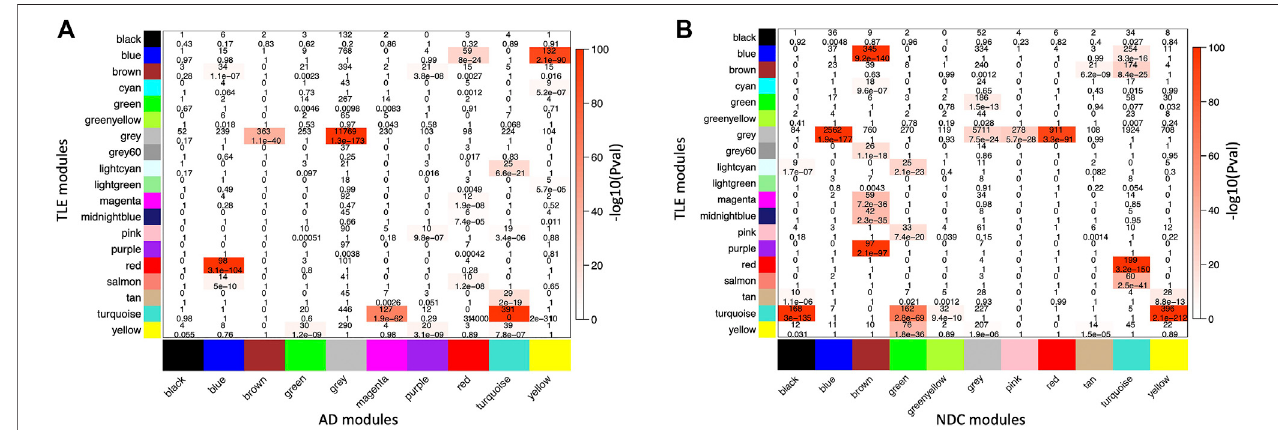
FIGURE 3 | Cross-tabulation of TLE modules (in Y axis) against (A) AD and (B) NDC modules (in X axis). Each axis is labelled by the corresponding module colour. Each block in thetableshows the number ofoverlapping genesin the intersection ofcorresponding (A) TLE and AD and (B) TLEand NDCmodules.The table is colour- coded with -log10 of the p value associated with the Fisher exact test.